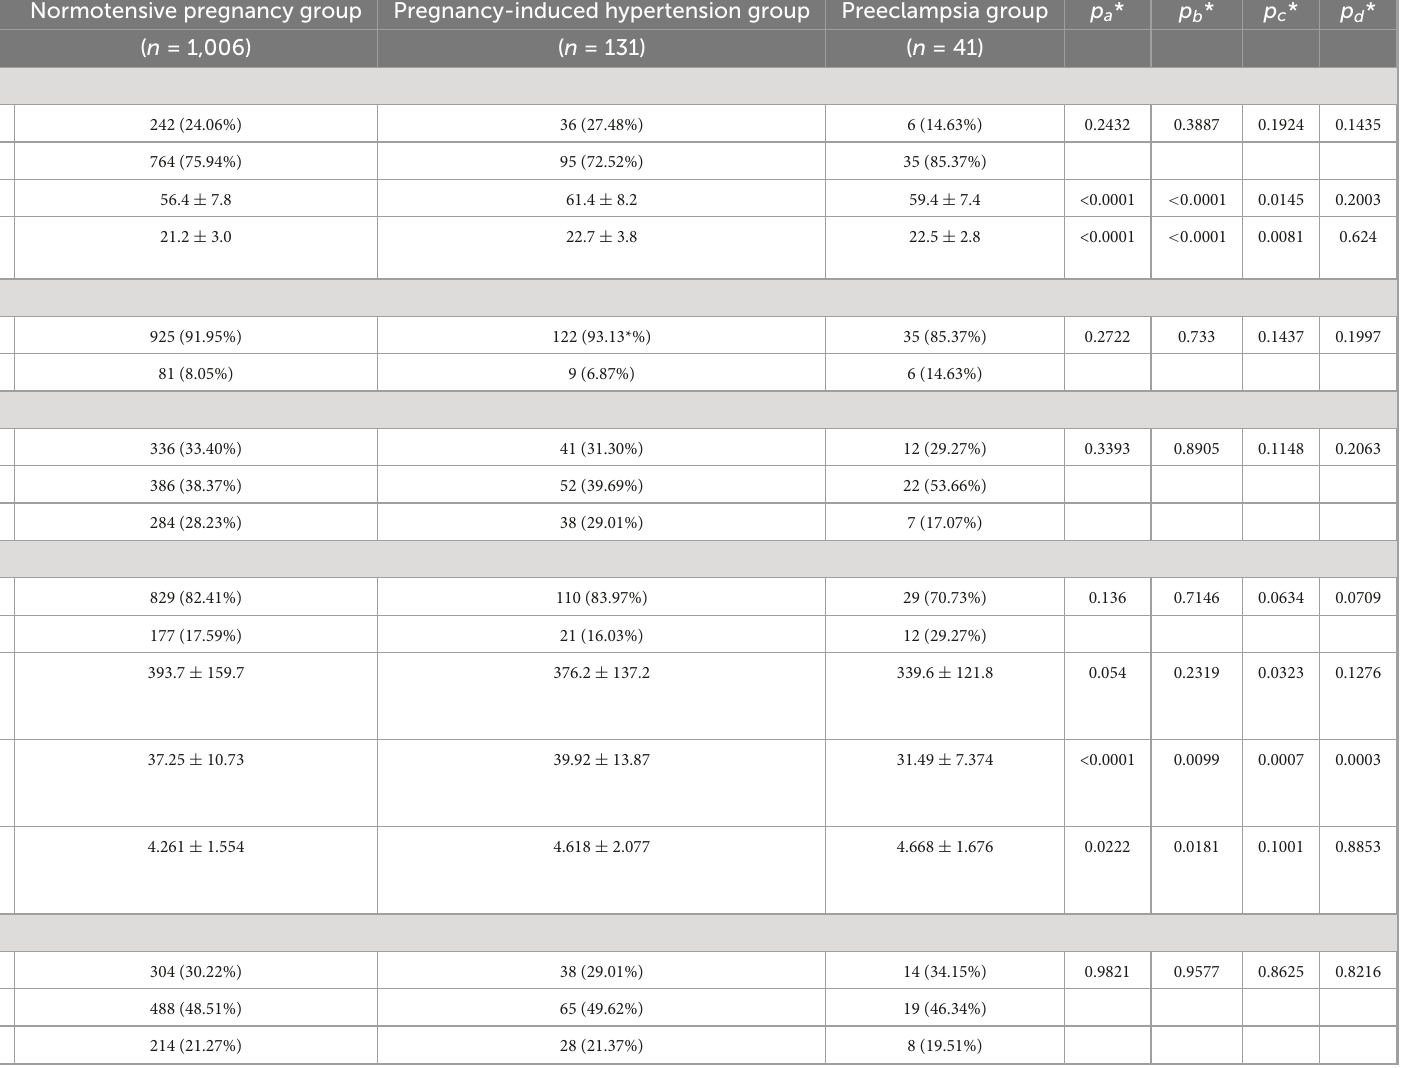
TABLE 1 Comparison of general information, serum parameters, and MTHFR C677T genotype of three groups of research subjects. n